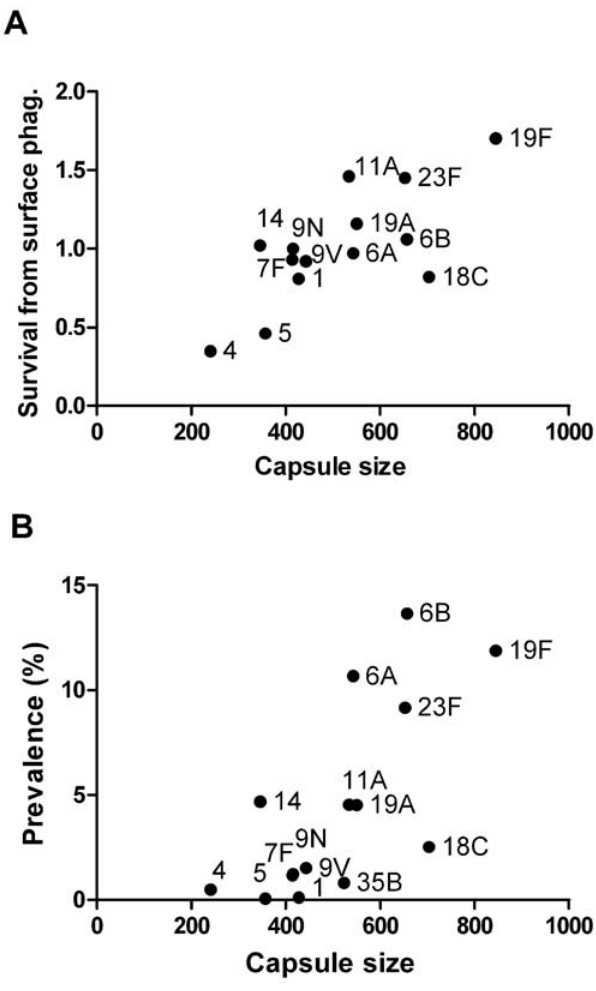
Figure 2. Relationship between degree of encapsulation, resistance to neutrophil-mediated killing, and carriage preva- lence. Capsule size, as evaluated by FITC-Dextran exclusion, is related to A) avoidance of neutrophil-mediated killing ( r =0.58, p , 0.05) and B) carriage prevalence ( r =0.68, p , 0.01). The mean area of the zone of FITC-dextran exclusion, including the bacterial body and capsule, is shown. 100–250 cells per serotype were measured, and the zone of exclusion for unencapsulated TIGR4 was 286